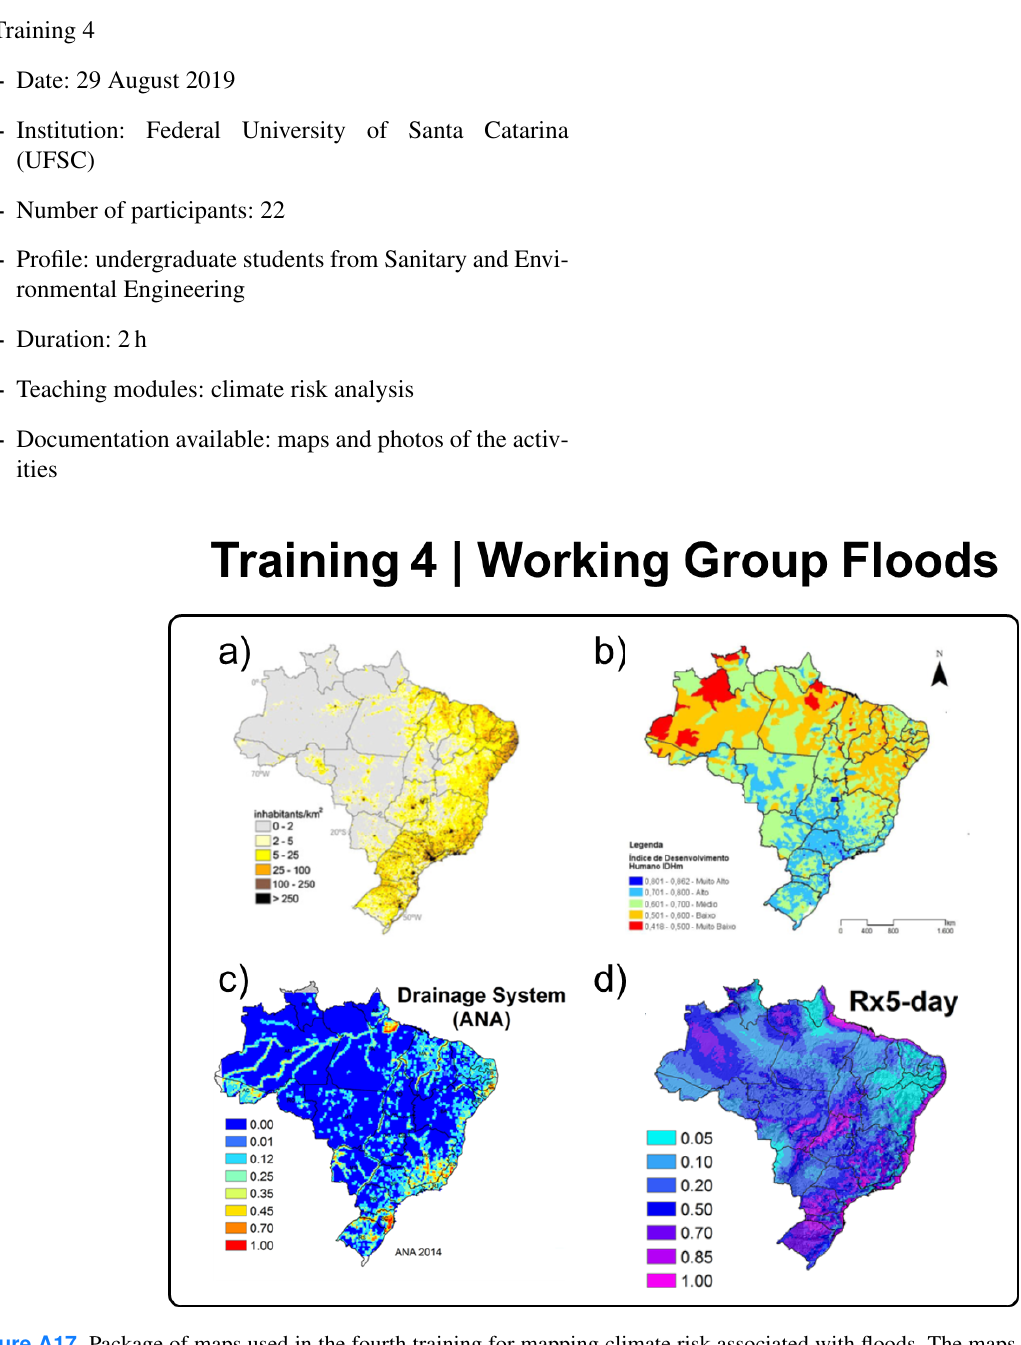
Figure A17. Package of maps used in the fourth training for mapping climate risk associated with floods. The maps illustrate (a) Brazilian population density (Torres et al., 2012), (b) Human Development Index (HDI; MMA 2017), (c) watershed drainage (Debortoli et al., 2017), and (d) maximum consecutive 5d precipitation (Rx5-day; Debortoli et al.,